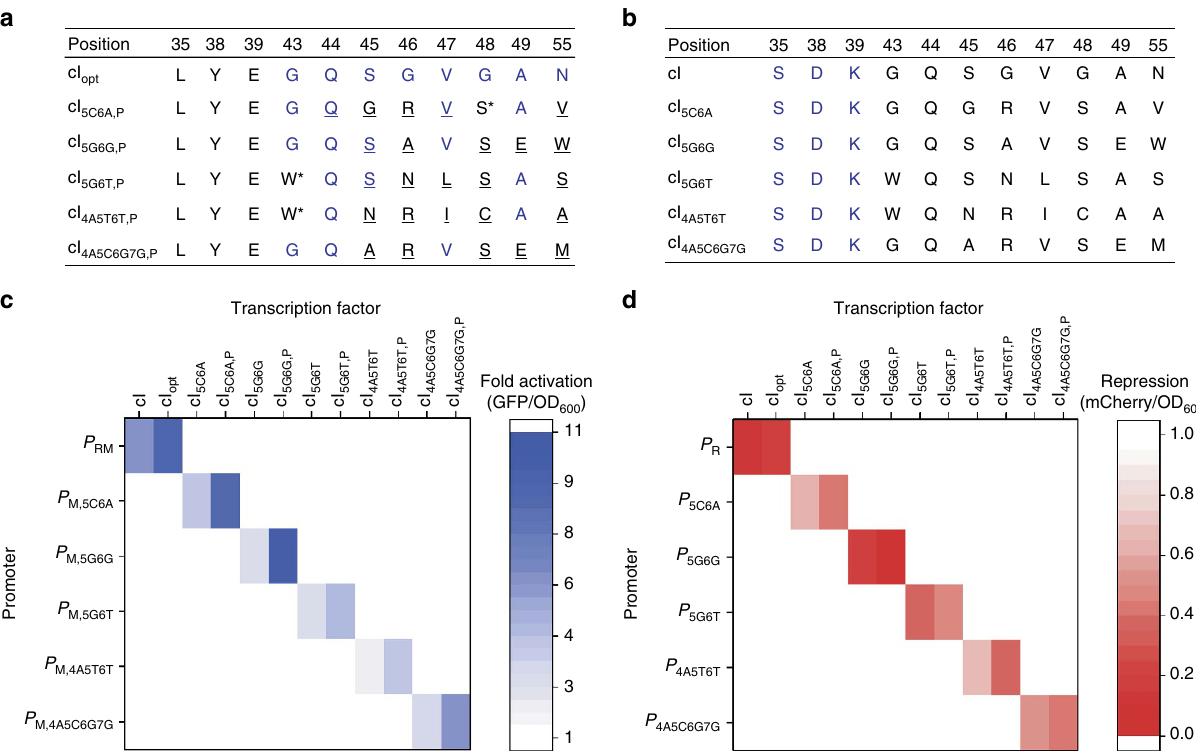
Figure 4 | Selection and characterization of cI library members. ( a ) Sequencing results of selected cI variants against synthetic promoters while counterselecting against wild-type binding. Wild-type amino acids are highlighted in blue, randomized positions are underlined and evolved amino acids that were not part of the combinatorial library are annotated with an asterisk. ( b ) The selected cI variants were re-engineered by rational design (35S, 38D, 39K, highlighted in blue) in order to obtain activators with varying strengths. ( c ) Fold-activation of engineered l P M promoters by selected cI variants. Stronger activation domain mutants are denoted by a ‘ P ’ (for example cI 5C6A,P ). ( d ) Repression of engineered l P promoters (0.0 ¼ 100% repression). GFP and mCherry expression was normalized to OD 600 and data were obtained from four replicates. Activation and repression were normalized to the basal expression of each promoter in the absence of a